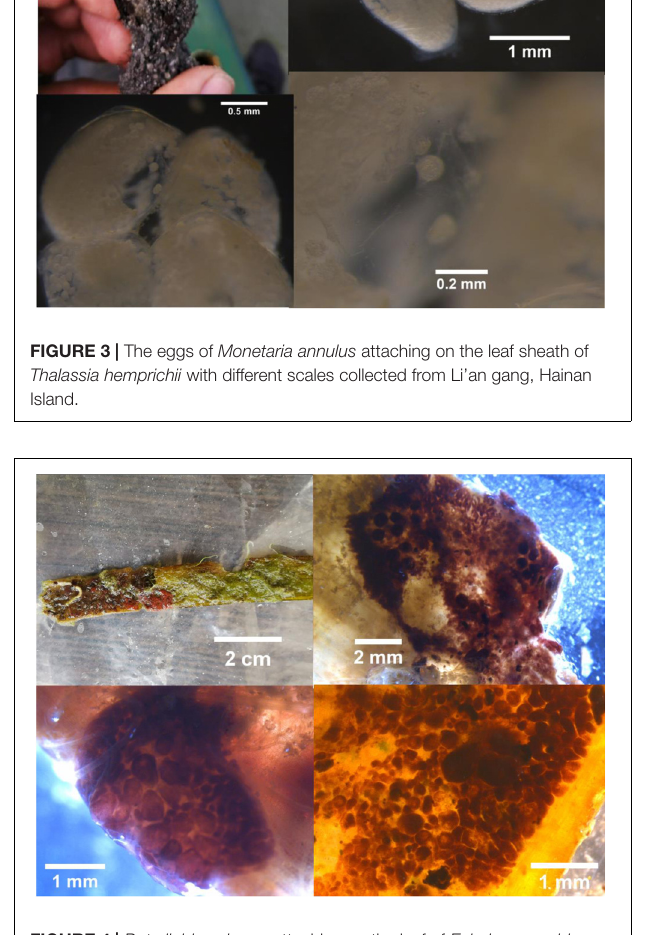
temperate and sub-tropical areas, respectively (Villamor, 2015).